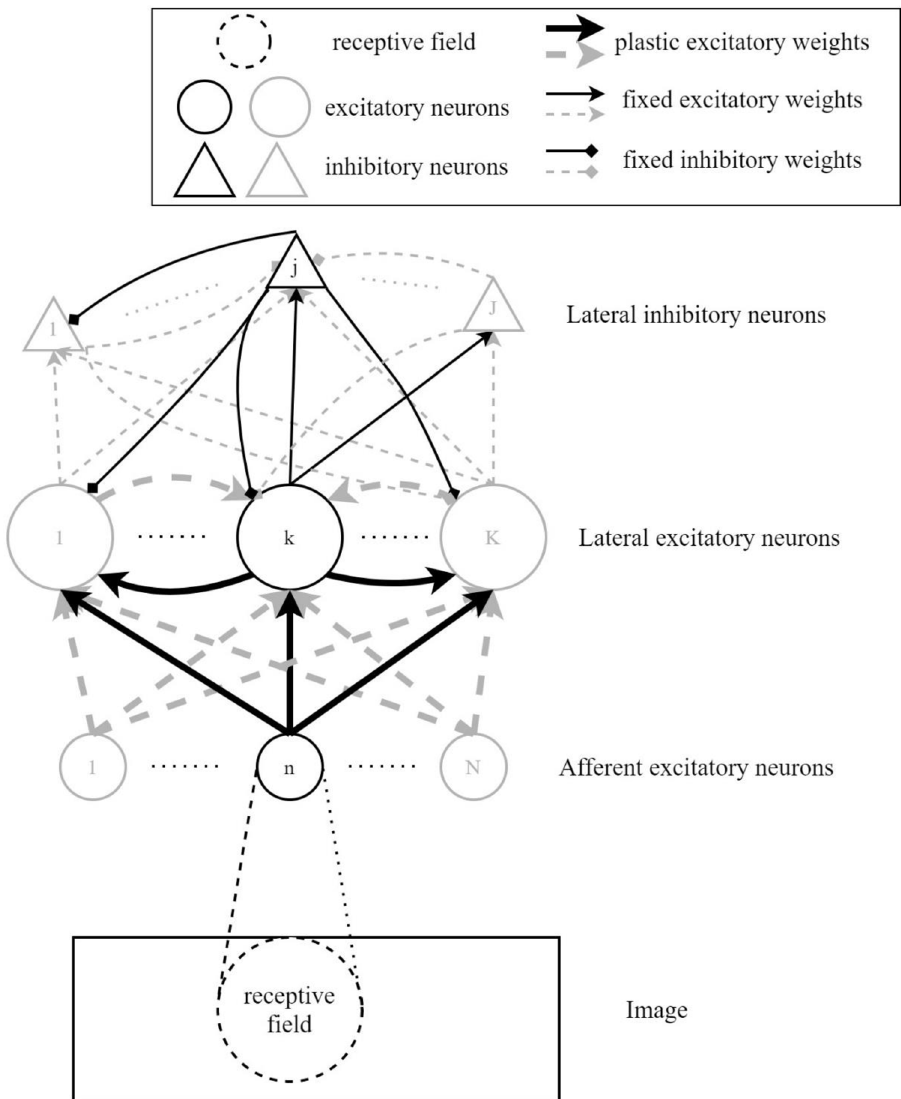
Figure 1. The construction of the designed k-WTA spiking network. Solid circles indicated excitatory neurons. Solid triangles indicated inhibitory neurons. The network contained first-layer afferent excitatory neurons, second-layer excitatory neurons and second-layer inhibitory neurons. Lines with arrows indicated excitatory connections. Lines with squares indicated inhibitory connections. Plastic connections were represented by thick lines. Fixed connections were represented by thin lines. The dotted circular region within the bottom image indicated the afferent neural receptive field. Afferent neurons were induced by stimuli within receptive fields to generate Poisson